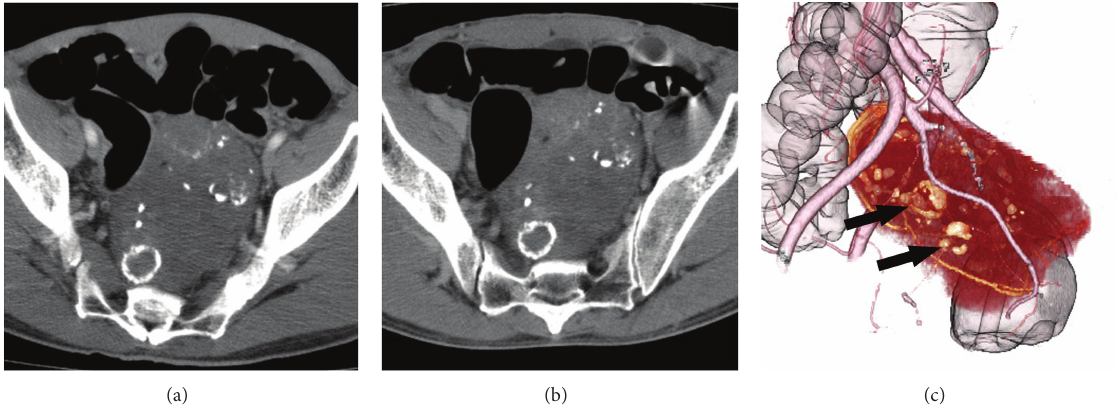
Figure 1: (a) Contrast-enhanced CT shows a low-density mass containing coarse and round calcifications in early phase (40s). Cystic lesions are not evident. (b) The mass is slightly enhanced in delayed phase (180s). (c) 3D-CT shows eggshell-like calcifications within the tumor (arrows).